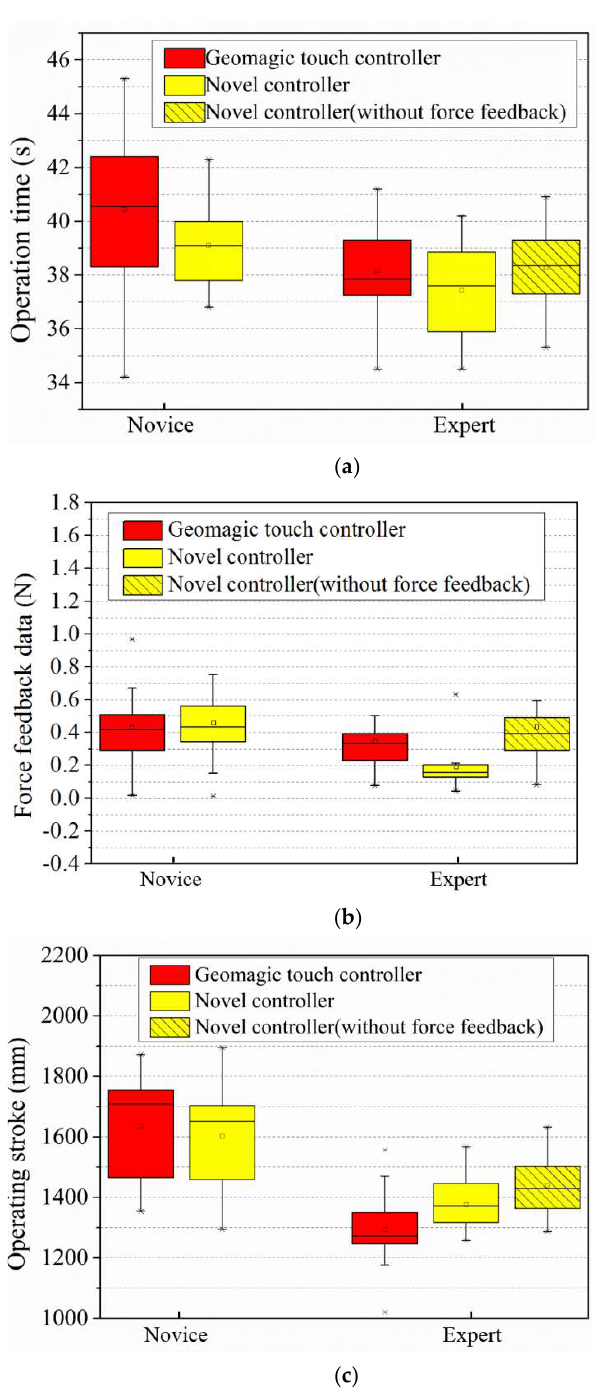
Figure 14. Experimental results of the comparison between the operation of the previously used controller and the novel controller. ( a ) Comparison results of the operation time. ( b ) Comparison results of the force feedback data. ( c ) Comparison results of the operation stroke.